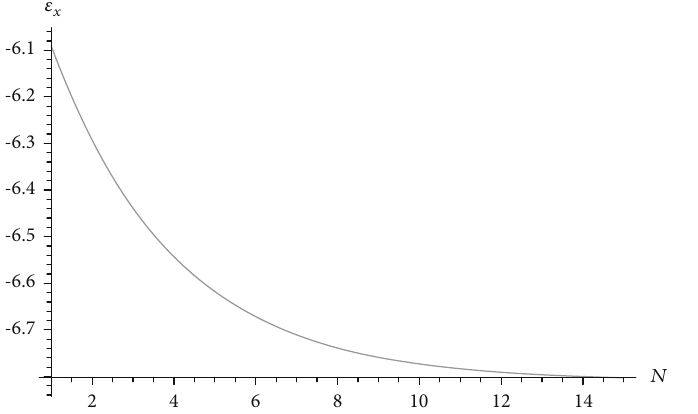
Figure 10: Shows the variation of perturbations along the x -axis ( ϵ